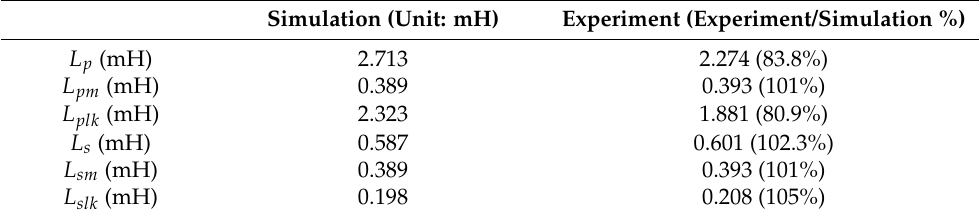
Table 5. Measured inductance.